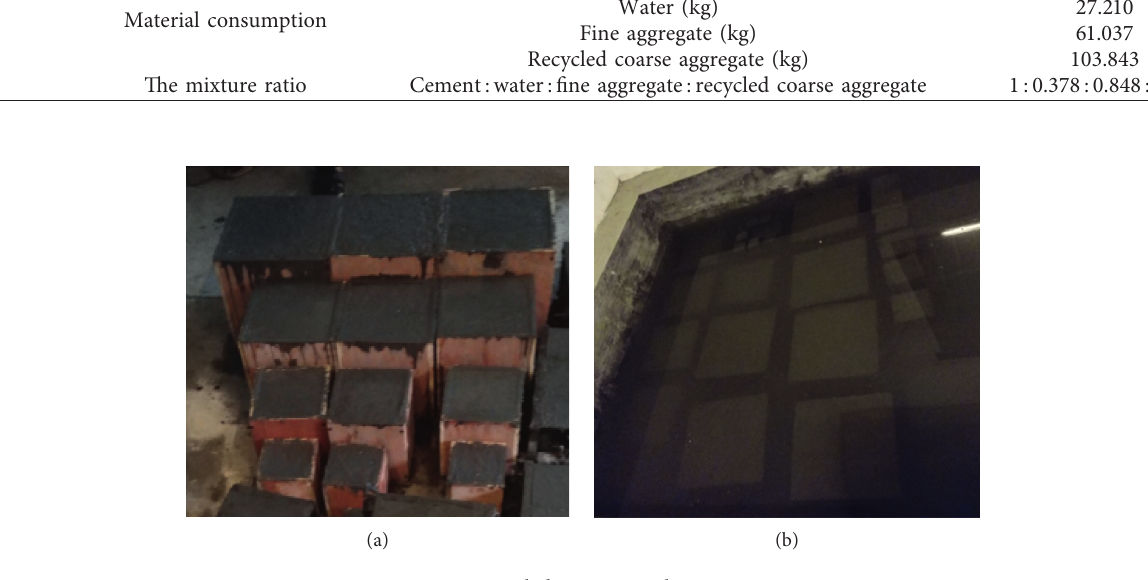
Figure 3: Recycled concrete cube specimens.